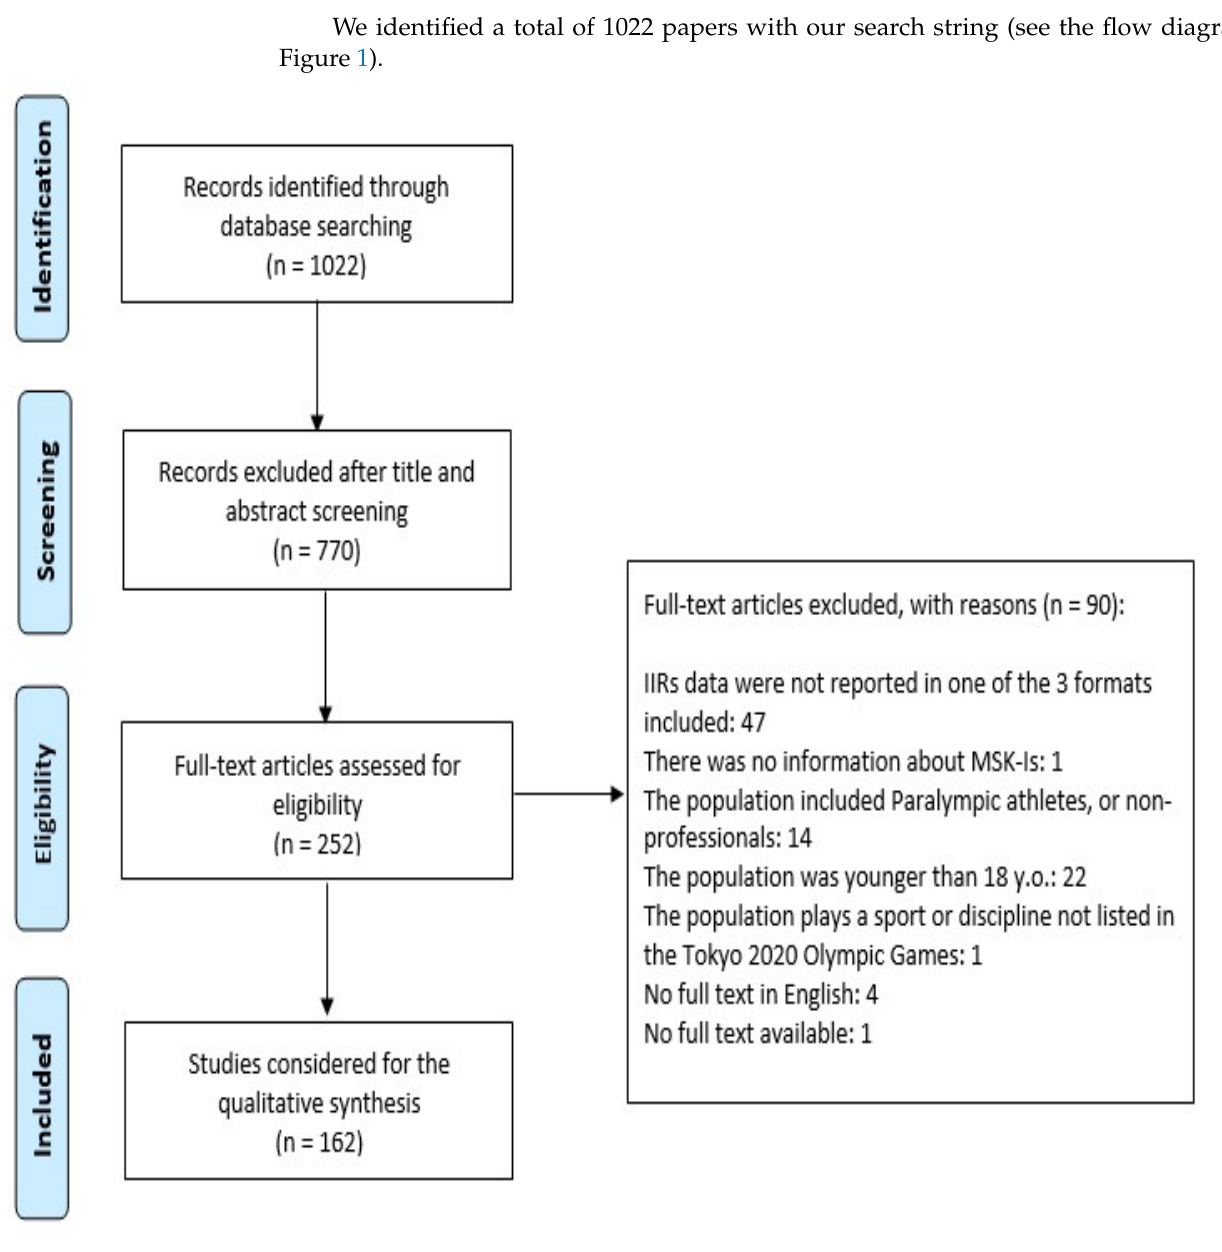
Figure 1. PRISMA-ScR flow chart of the study selection process.